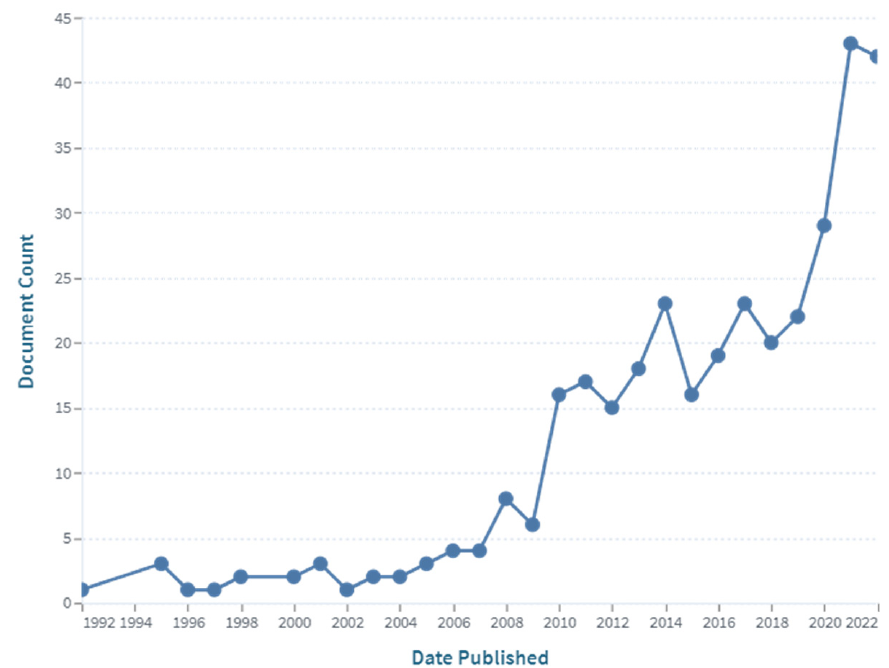
Figure 1. The number of publications with the keyword “cellulose–chitosan” (in the abstract) over time (source: www.lens.org; accessed on 21 December 2022).